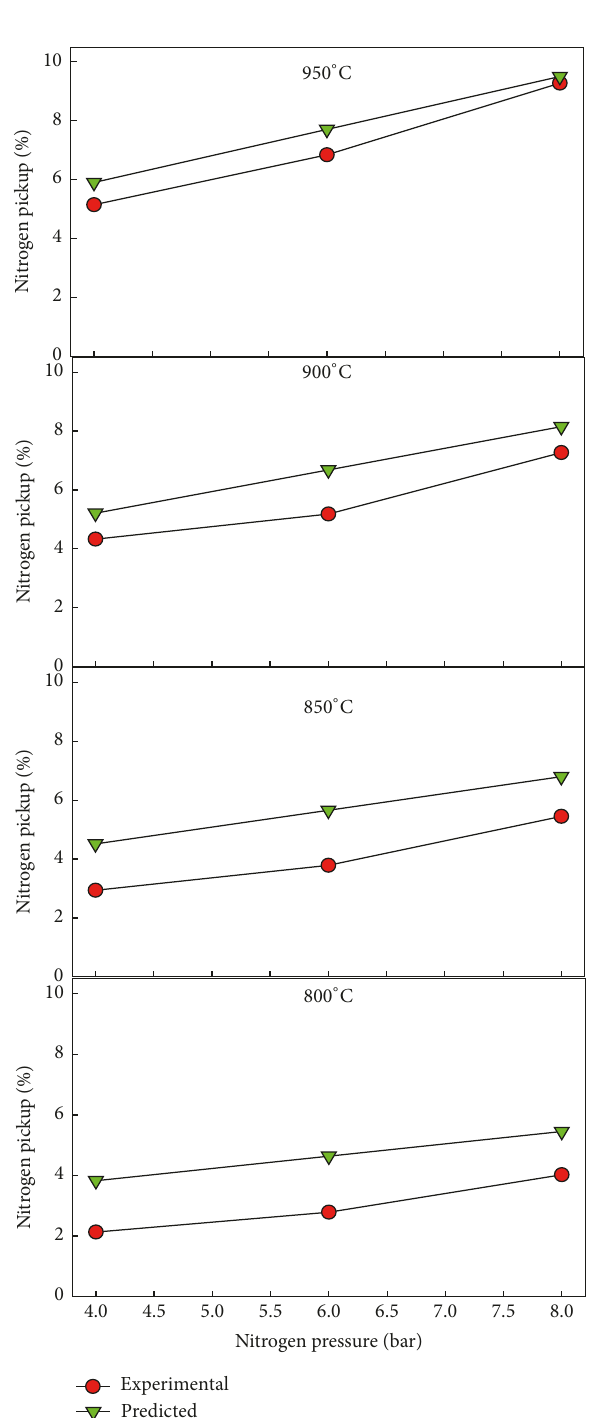
Figure 5: Variation between the predicted and published nitrogen pickup of low carbon (0.23% C) ferromanganese at 6 hours and at different nitrogen pressure and temperature [28,